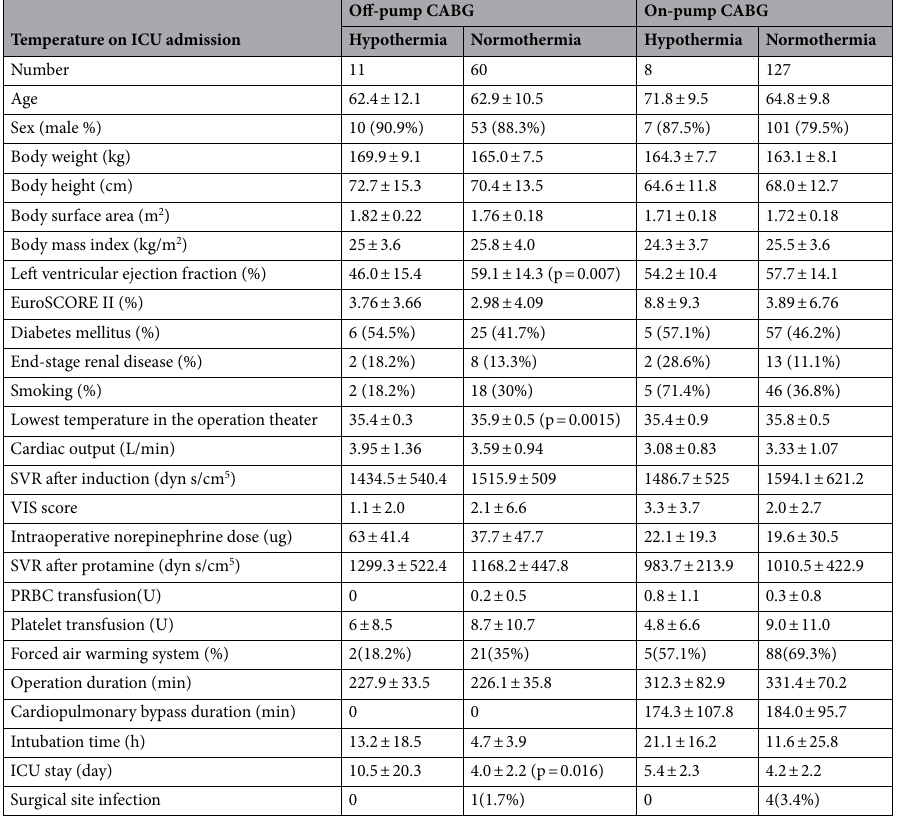
Table 2. Characteristics of hypothermia and normothermia patients in Off-pump and On-pump coronary artery bypass surgery groups. Values are mean ± SD or number (proportion). PRBC packed red blood cell, VIS vasoactive inotropic score, ICU intensive care unit; Hypothermia defined as blood temperature < 36 C; SVR Systemic vascular